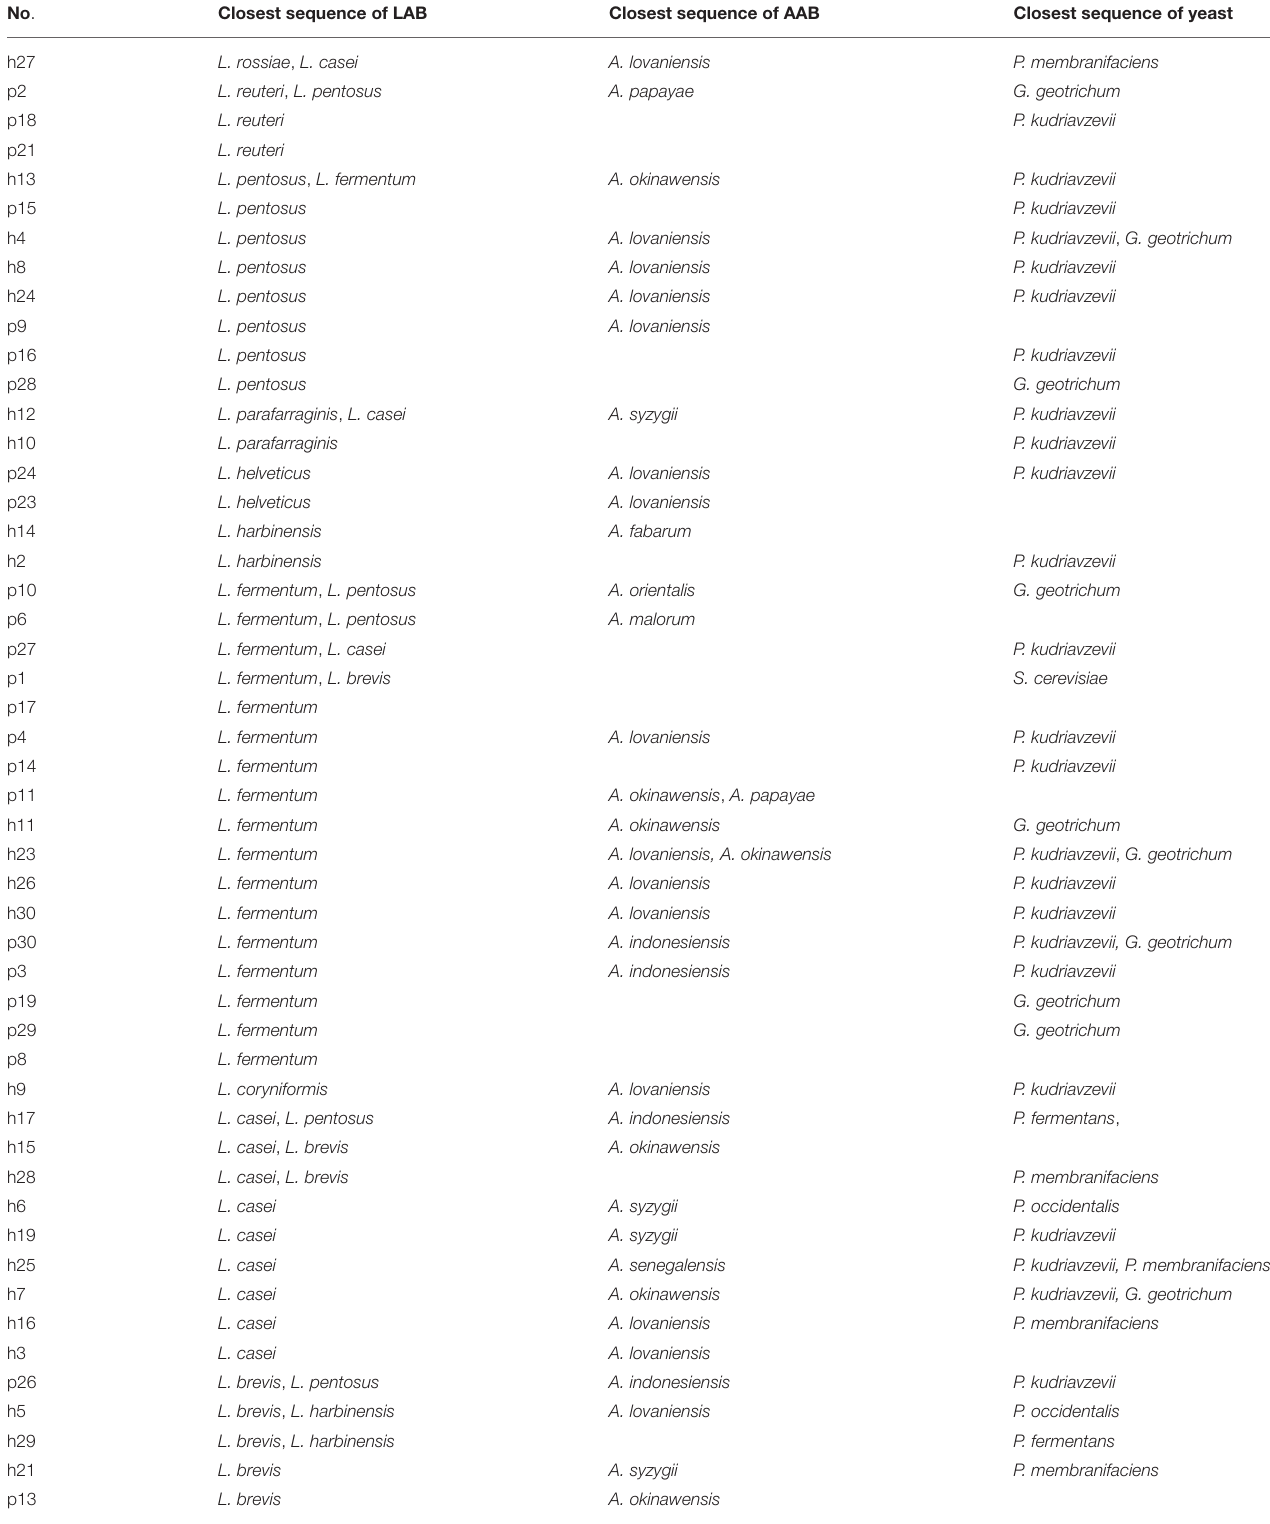
TABLE 1 | Phylogenetic affiliations of the isolates. No . Closest sequence of LAB Closest sequence of AAB Closest sequence of